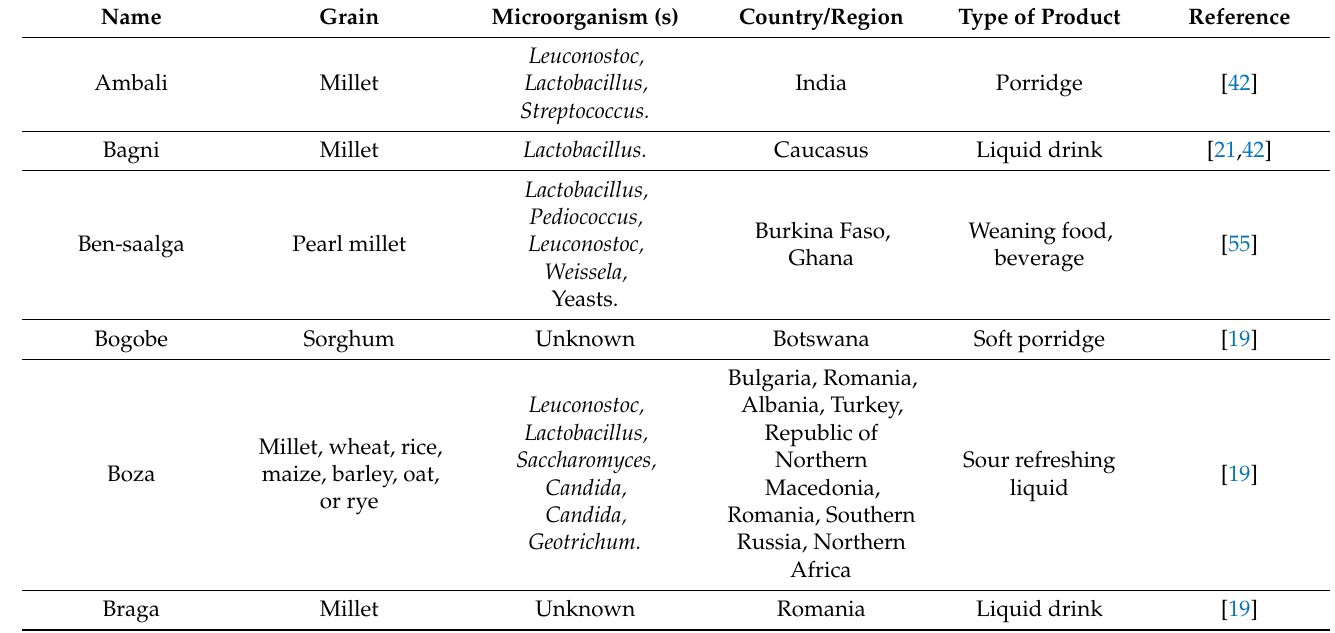
Table 2. Examples of lactic- and acetic-fermented MGs and non-alcoholic porridge and beverages used in different regions of the